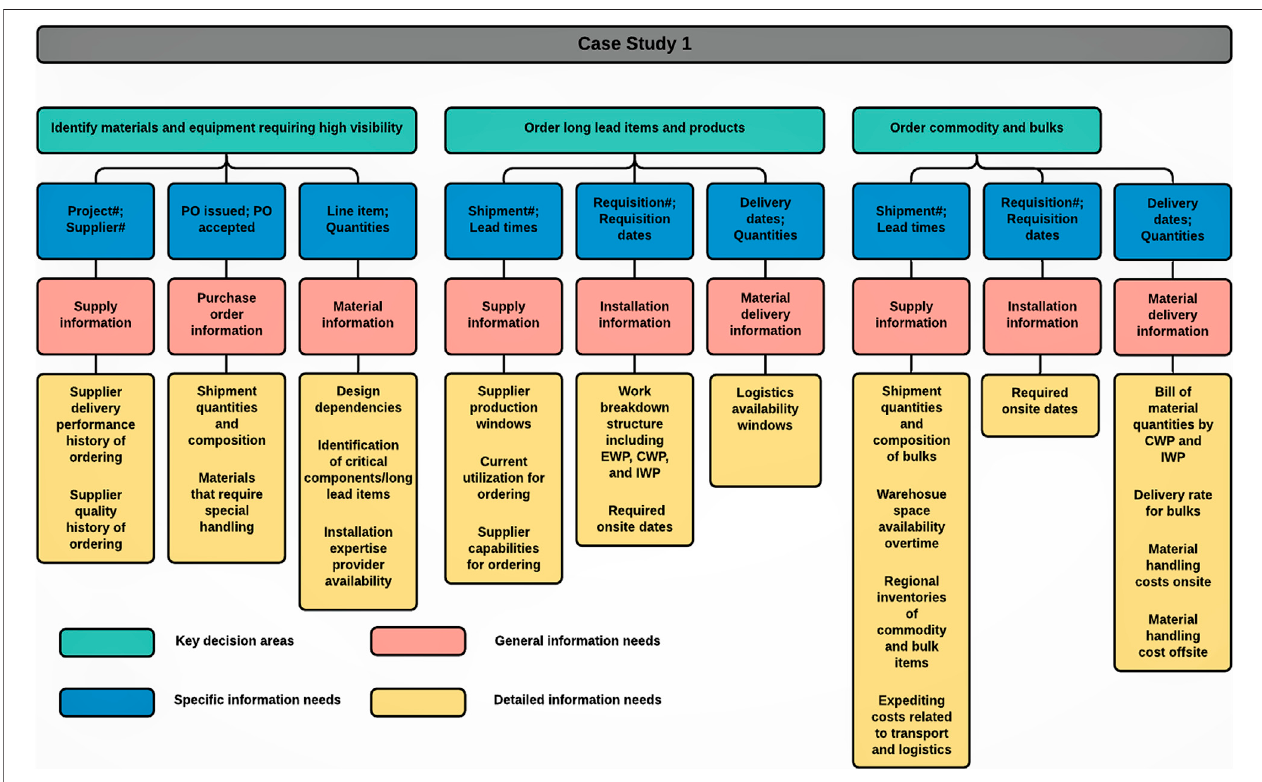
FIGURE 2 | Process of fi nding the detailed information needs to support key decision areas for mini-case CS1.